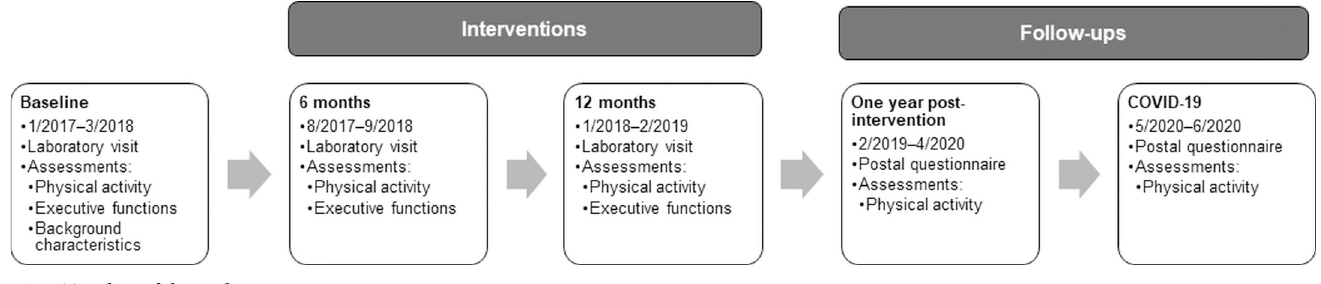
Fig 2. Timeline of the